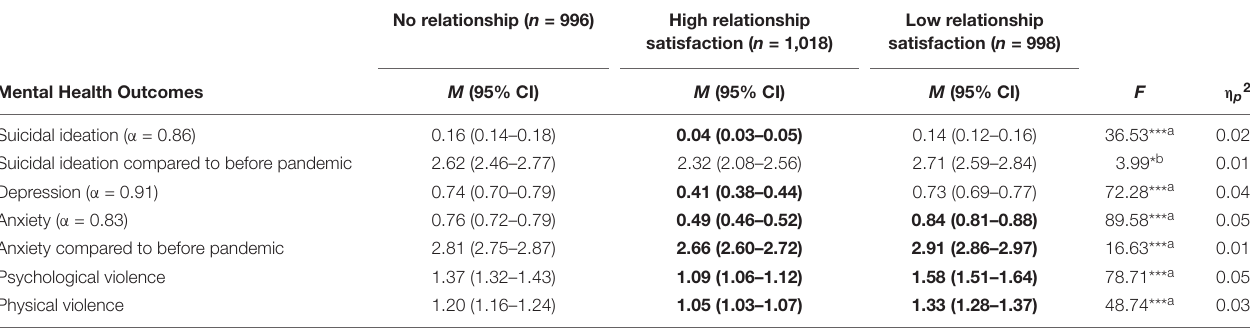
TABLE 2 | Mental health among participants with high and low relationship satisfaction and participants currently not in a relationship ( n = 3,012).